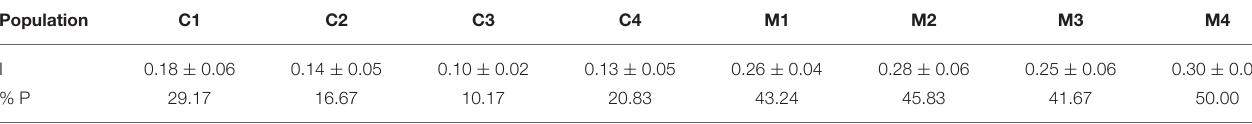
TABLE 2 | Shannon’s Information Index I and percentage of Polymorphic Loci (% P) of bacteria isolates from the eight treatments based on ARDRA analysis. Population C1 C2 C3 C4 M1 M2 M3 M4 I 0.18 ± 0.06 0.14 ± 0.05 0.10 ± 0.02 0.13 ± 0.05 0.26 ± 0.04 0.28 ± 0.06 0.25 ± 0.06 29.17